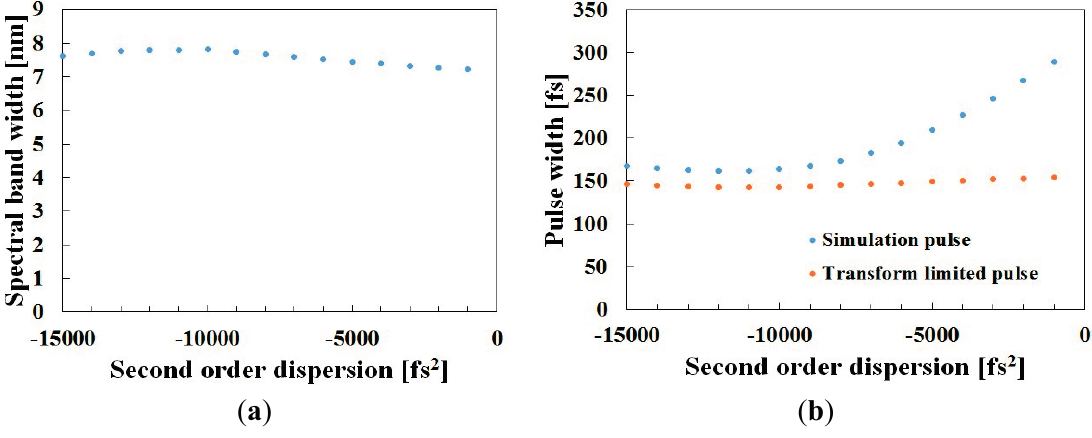
Figure 3. ( a ) Output spectra and ( b ) output pulse profiles for a cavity loss of 40%.